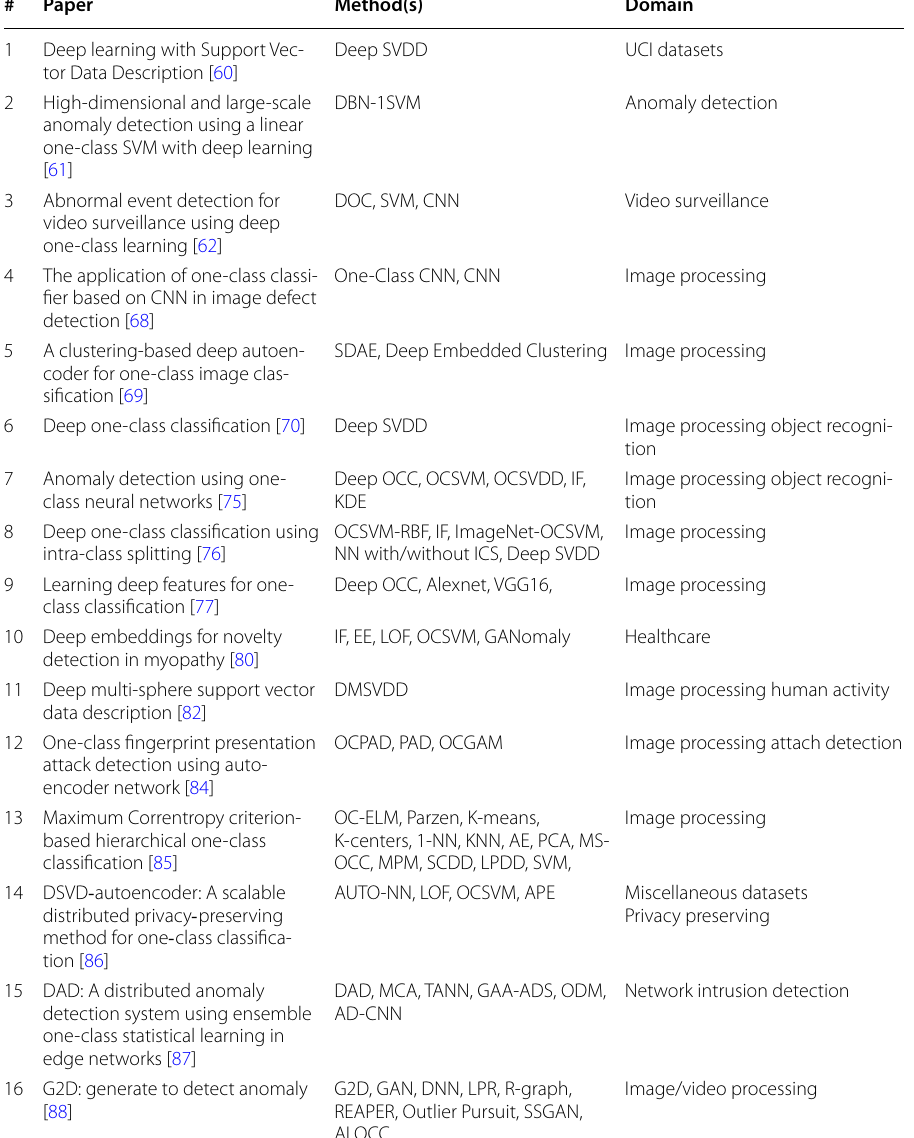
Table 3 Surveyed works on deep learning and